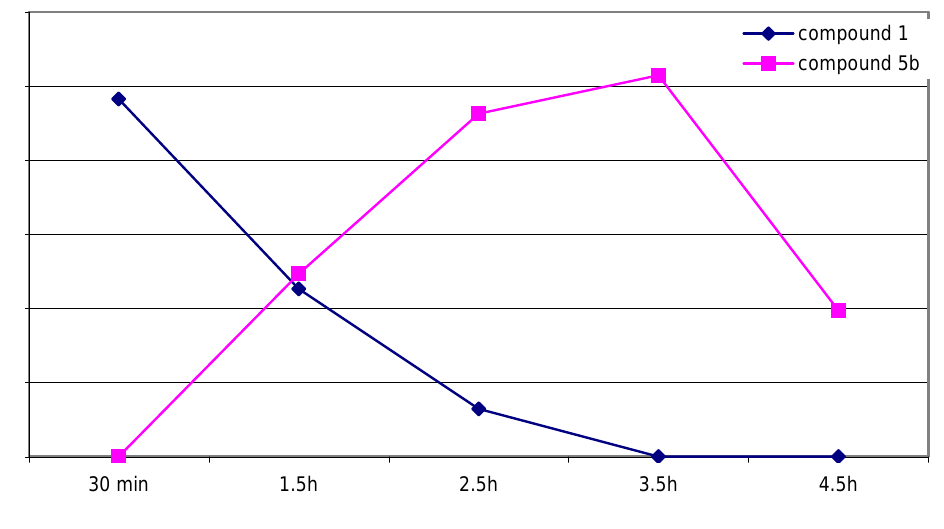
Figure 1 : The course of reaction expressed as areas under the curve